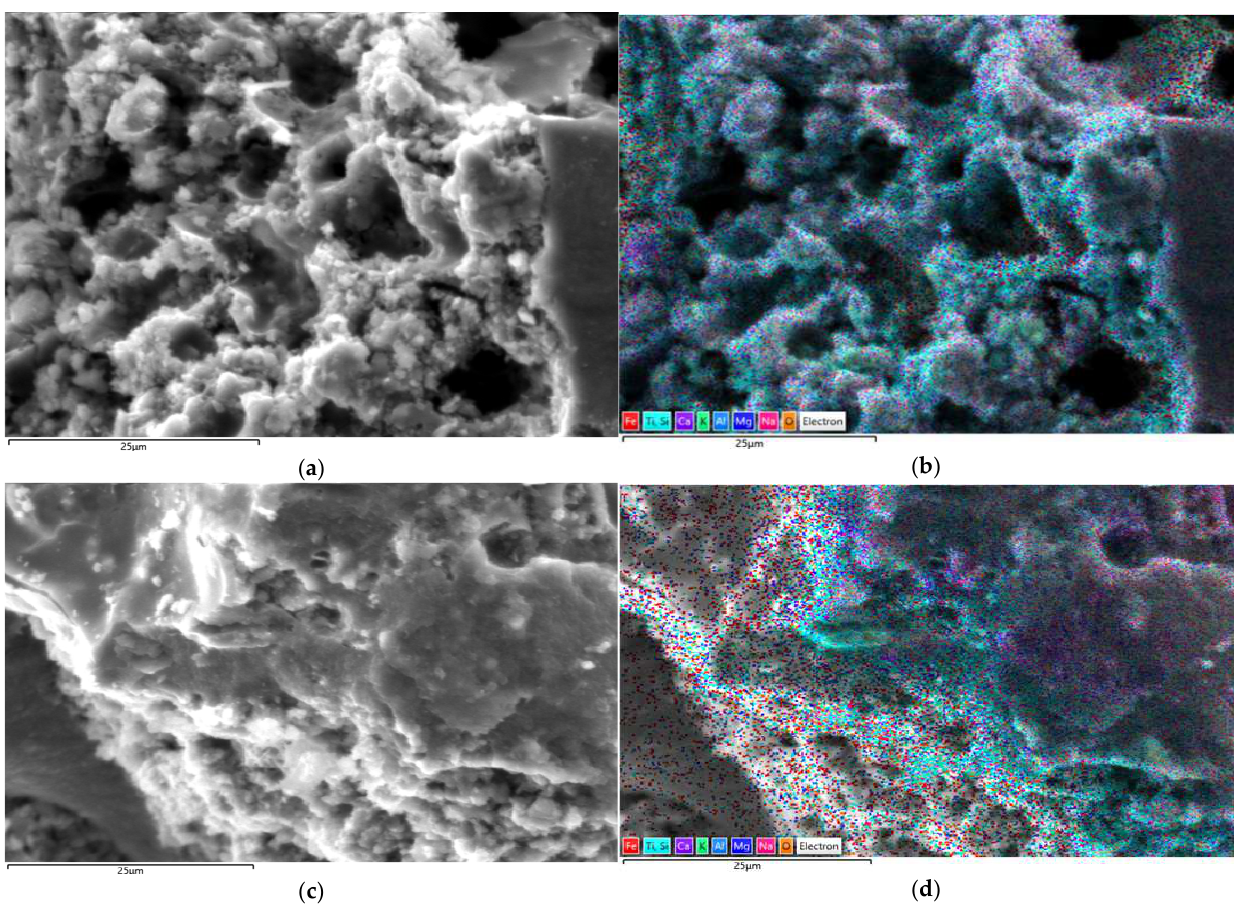
Figure 11. EDS analysis for sample 8M: ( a ) SEM image of selected area and ( b ) EDS layered image of selected area; for sample 8MX1: ( c ) SEM image of selected area and ( d ) EDS layered image of selected area.